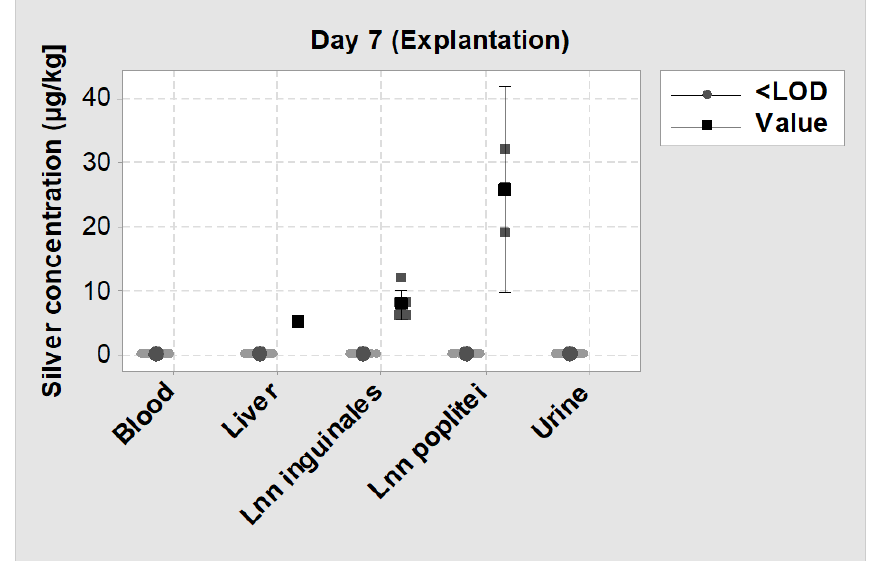
Figure 11. Individual value plot of silver levels measured by inductively coupled plasma mass spectrometry (ICP-MS) on day 7 (explantation) in blood, urine, liver and two lymph nodes. <LOD = Silver concentration was below the detection limit; Value = Silver concentration could be measured. The big symbols represent the mean value of each group with a 95% confidence interval.